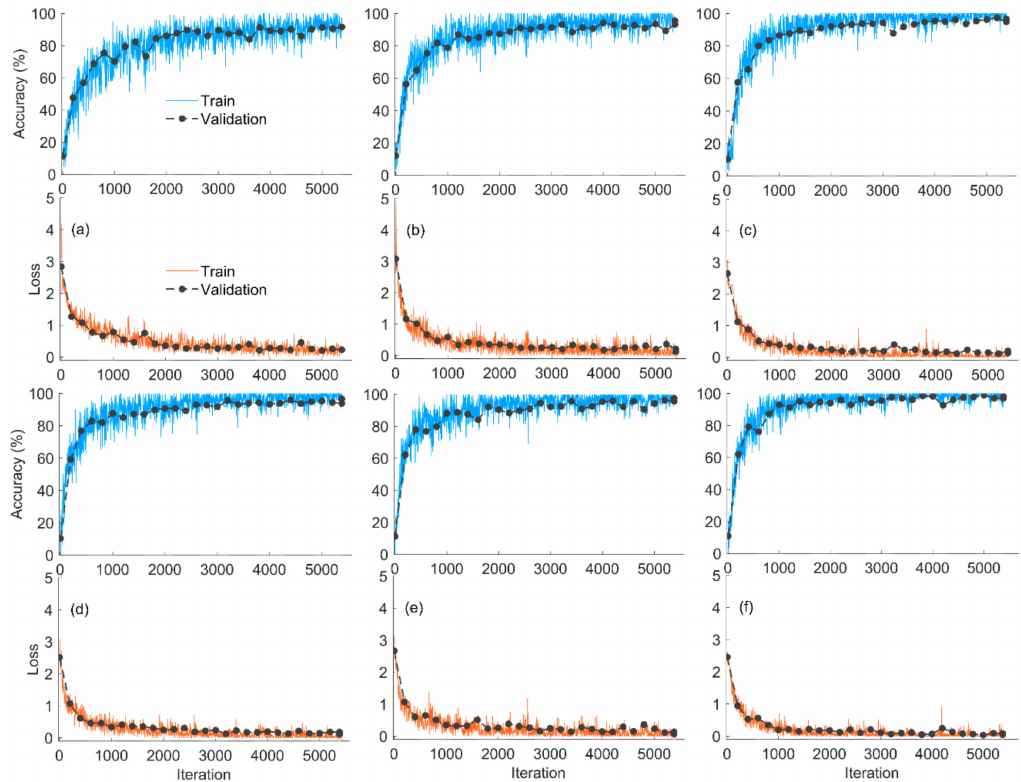
Figure 1. Training progress of the six pretrained models. ( a ) AlexNet; ( b ) ResNet18; ( c ) Xception; ( d ) InceptionV3; ( e ) DenseNet201; and ( f )